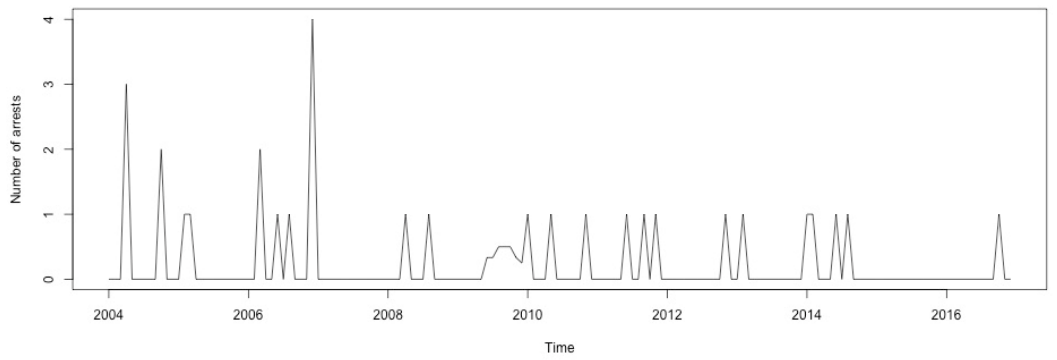
Figure A47. Heroin organized crime Czech nationals arrests 2004–2016 in the Czech Republic and structural breaks.